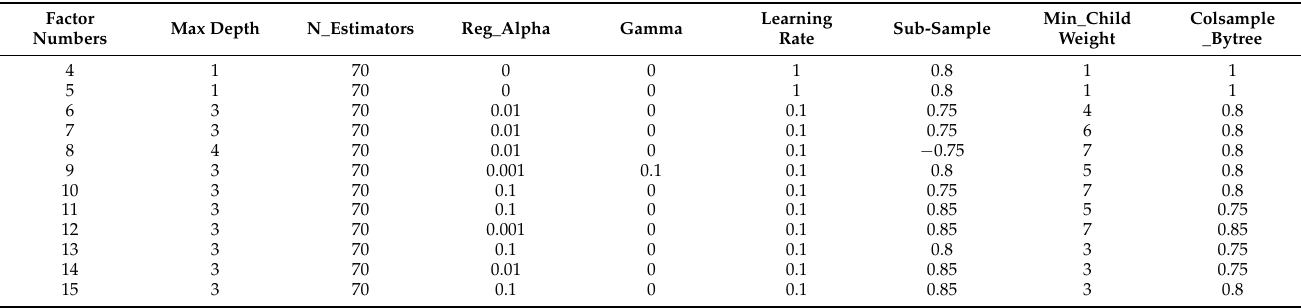
Table 8. Parameters of